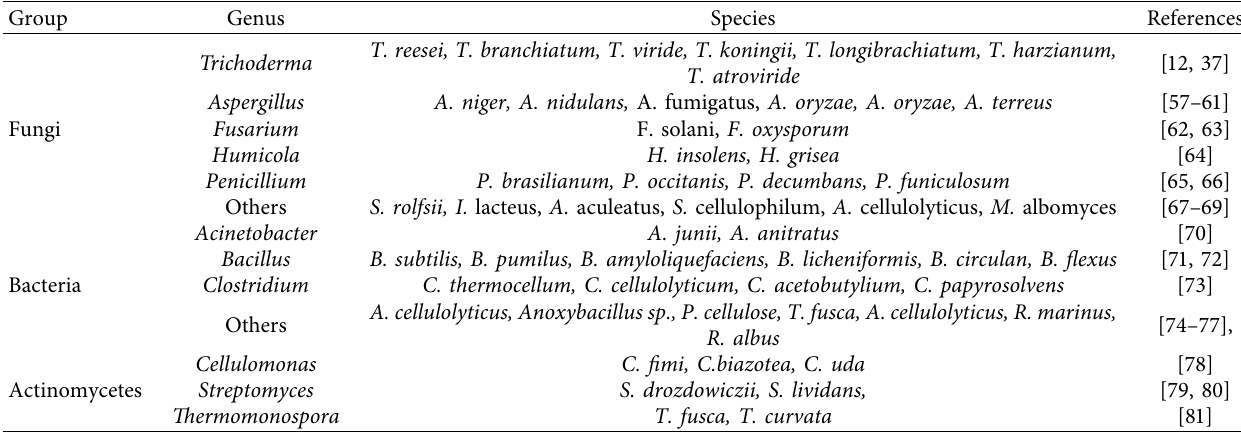
Table 1: Name of cellulase-producing